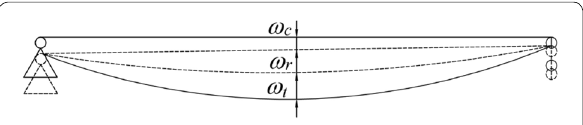
Fig. 11 The deflection of the test girder.